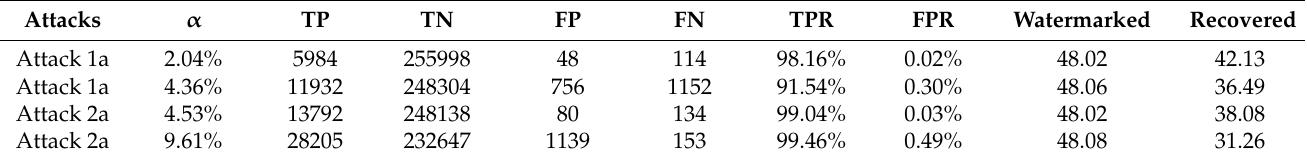
Table 6. Performance comparison of tamper detection and image quality against two types of attacks with different attack ratios.